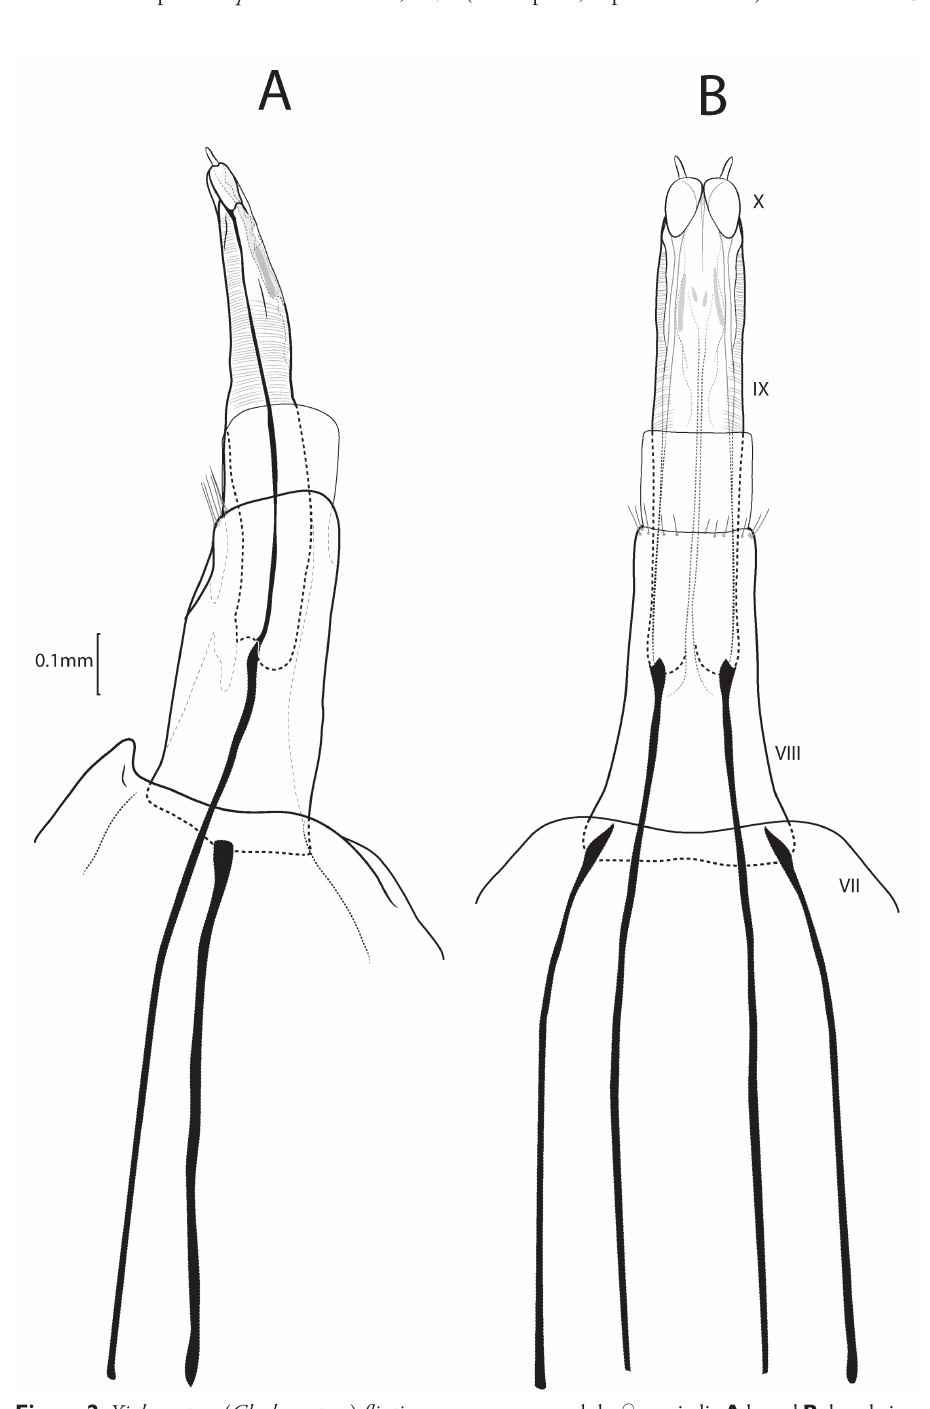
Figure 2. Xiphocentron ( Glyphocentron ) flinti sp. nov., paratype, adult, ♀ , genitalia A lateral B dorsal